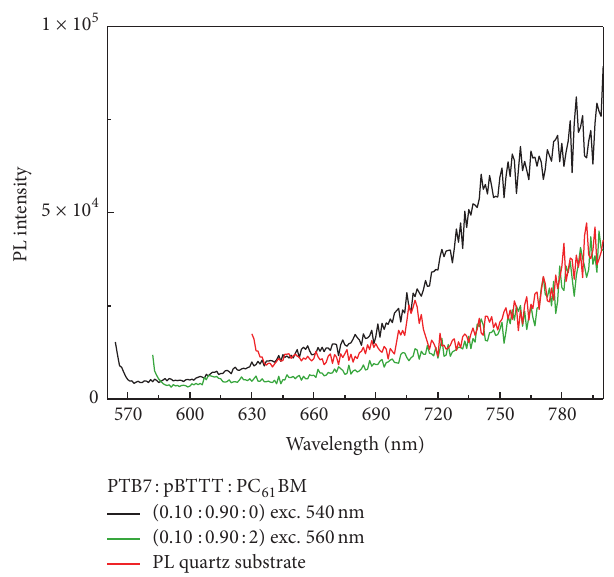
Figure 2: Photoluminescence spectra of films of the PTB7:pBTTT (0.1: 0.9) blend and of the same blend upon addition of PC 61 BM, deposited over quartz substrates, following excitation at the maxi- mum of absorption of pBTTT. For comparison, the spectrum of the bare quartz is also